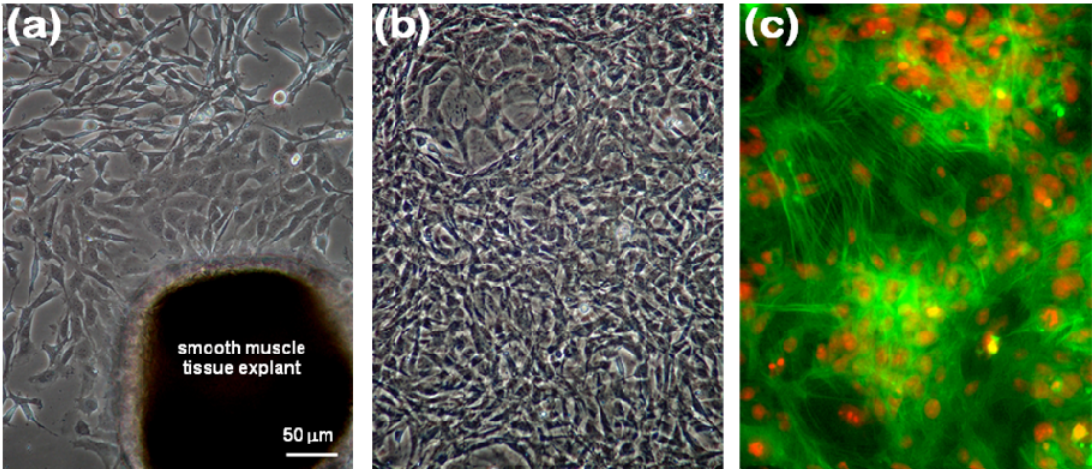
Figure 1. Optical microscopic photographs of primarily cultured VSMCs, (a) growing out of smooth muscle tissue explant of rat inferior vena cava (at 5 d after isolation) and (b) cultured for 4 d at passage 4. (c) Fluorescence microscopic photograph of VSMCs cultured for 2 d at passage 5, immunostained with FITC–SMA (green) and counterstained with PI (red) for nuclei. The micrographs (×200) shown in this figure are representative of six independent experiments, showing similar